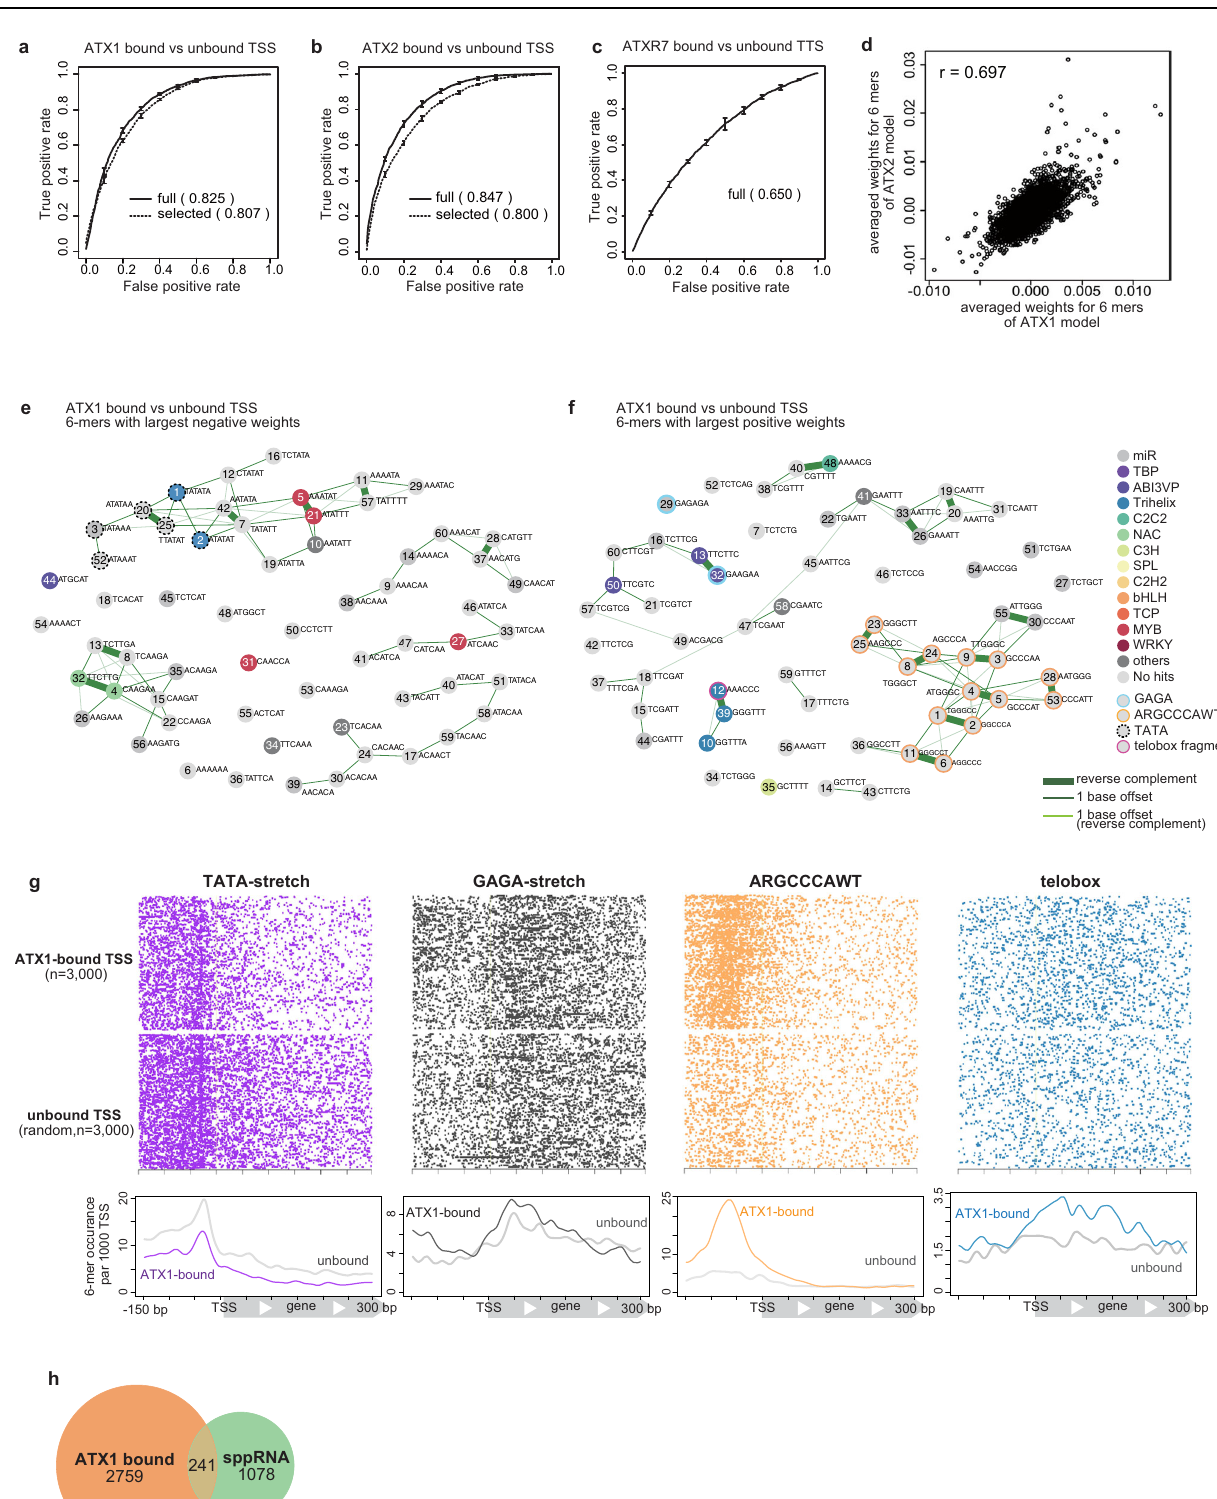
f ge ATX1 bound vs unbound TSS ATX1 bound vs unbound TSS 6-mers with largest positive